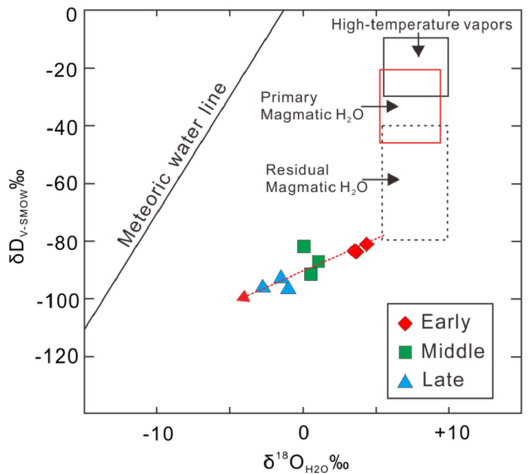
Figure 9. The quartz δD versus δ 18 O H2O diagram of the Baiyinhan tungsten deposit (Primary Magmatic H 2 O after Taylor, [76]; high-temperature vapours after Giggenbach, [77]; residual magmatic H 2 O after Taylor, [73]).